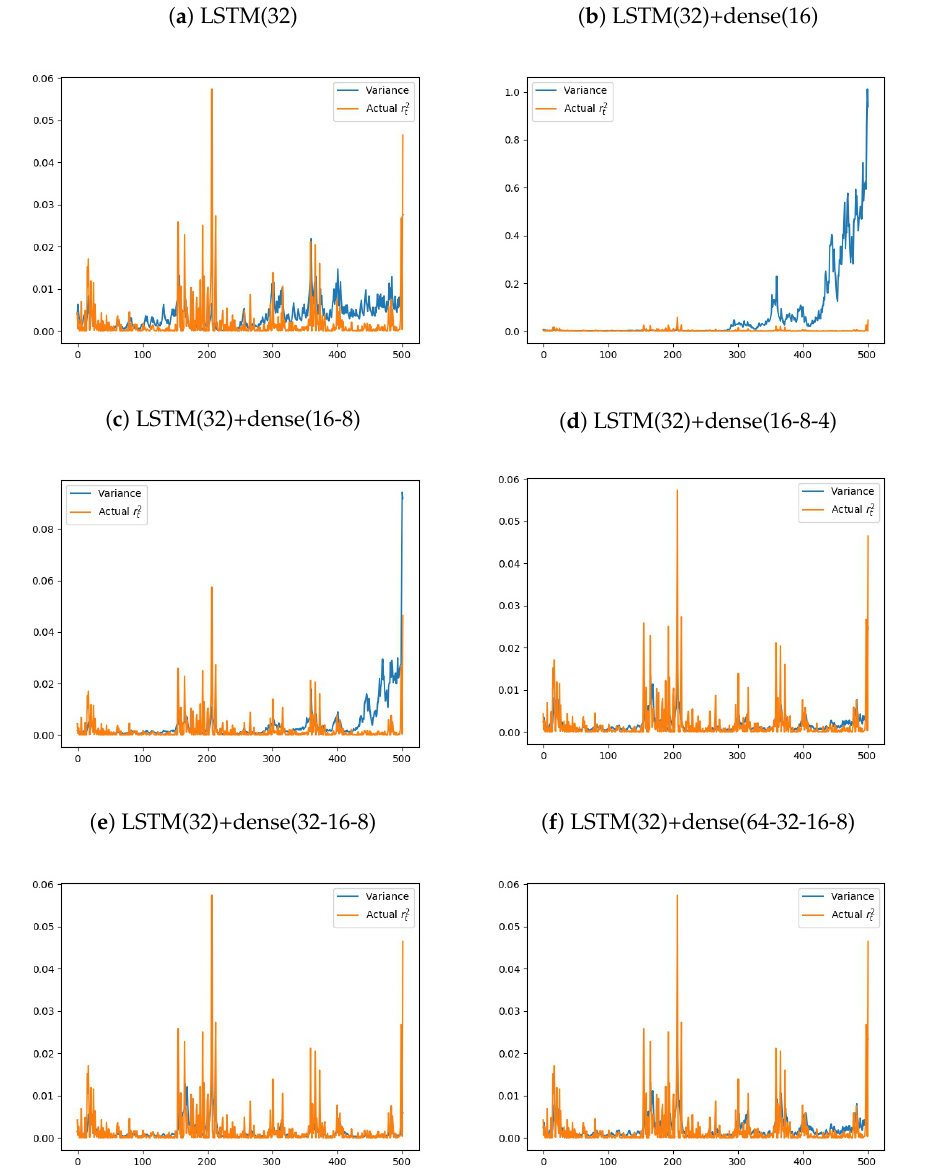
Figure 6. Actual r 2 and the predicted variance. To visualize the model performances, we plotted actual r 2 t and the predicted variance in the same graphs. Except for LSTM(32)+dense(32), actual r 2 variance are very